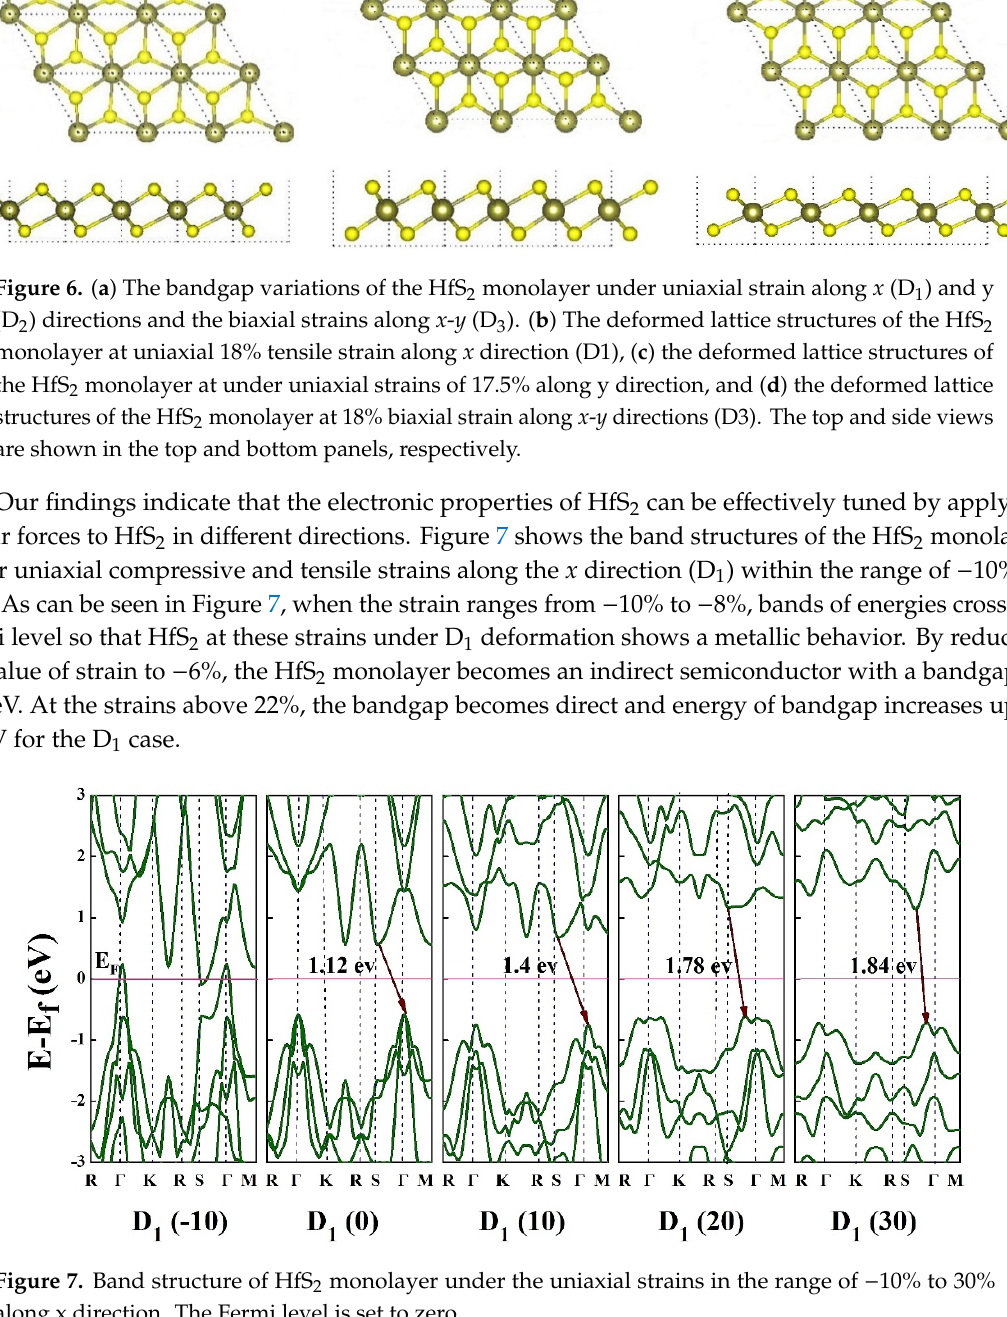
Figure 7. Band structure of HfS 2 monolayer under the uniaxial strains in the range of − 10% to 30% along x direction. The Fermi level is set to zero.